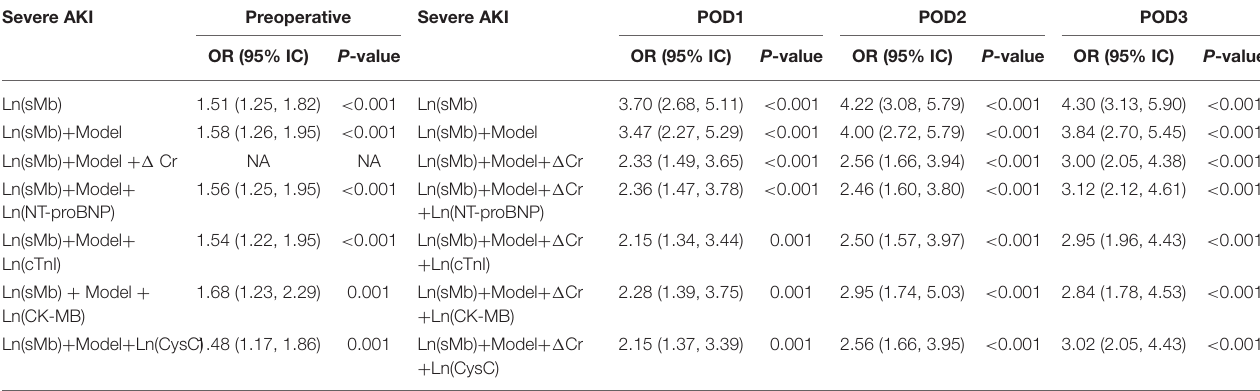
TABLE 3 | Association of Ln(sMb) with severe AKI. Severe AKI